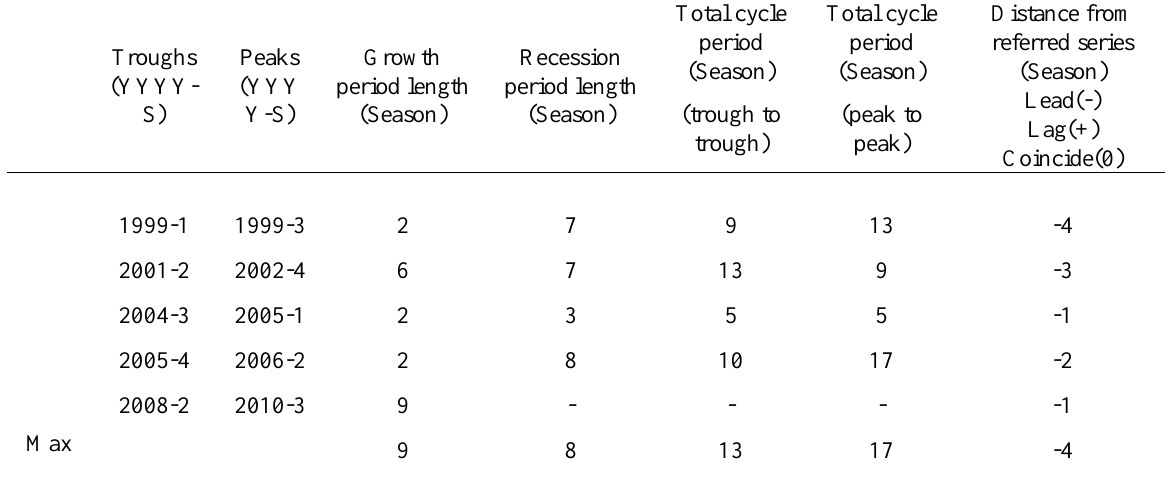
Table 4. Turning points of industrial establishment license and its comparison with reference series